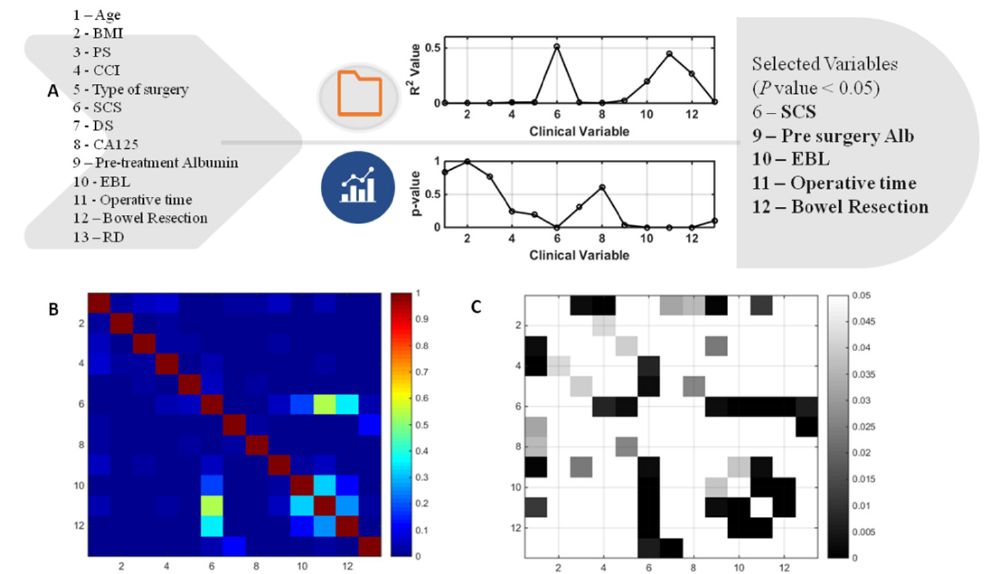
Figure 2. ( A ) Results of multivariate logistic regression leading to feature selection in the development of the predictive Machine Learning model. ( B ) Correlation heatmap representing the values of the determination co-efficient (R2) between the original variables entered for model development. Not surprisingly, the highest correlation was observed between surgical complexity and operative time. ( C ) Correlation heatmap representing the P values between the original system variables. In areas where there was no representation (square in any key), there was no significant correlation amongst variables ( p > 0.05). BMI; body mass index, PS; performance status, CCI; Charlson co-morbidity index, SCS; surgical complexity score, DS;disease score, EBL; estimated blood loss, RD; residual disease, Alb; albumin